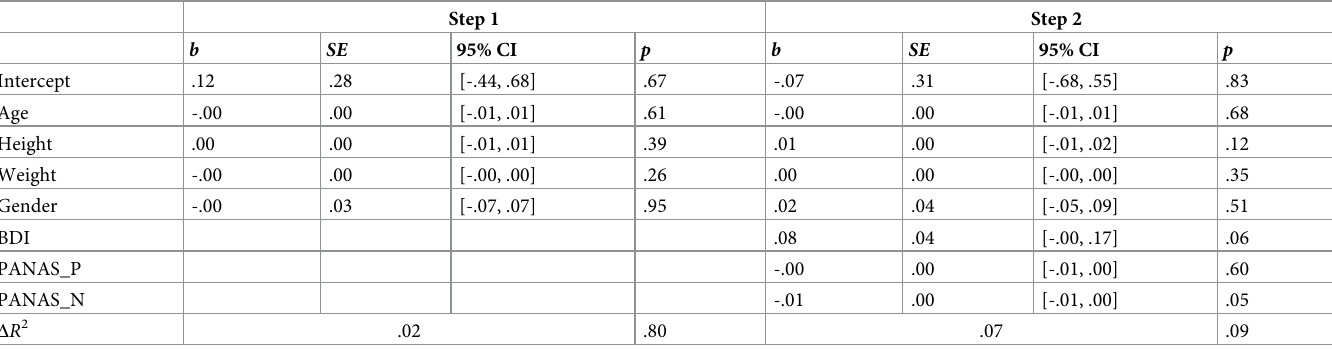
Table 5. Regression results for step